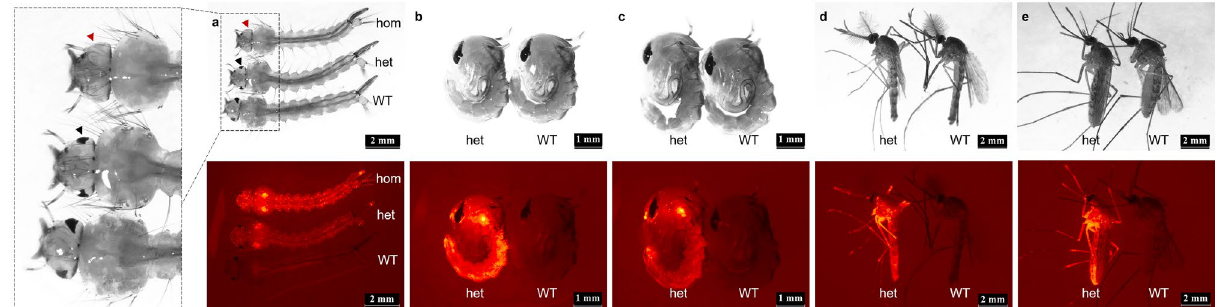
Figure 3. Phenotype of kmo knock-in in different life stages of C. quinquefasciatus (AGG2069 and wild-type). Photomicrographs of various developmental stages, in each case white light (top) and red fluorescence below. ( a ) late larvae. Pigmented eyes are clearly visible in wildtype (WT) and heterozygotes (het, one eye is indicated with a black arrowhead); this eye pigment is missing in homozygotes (hom, one eye indicated with red arrowhead). ( b ) Male pupae ( c ) Female pupae ( d ) Male adults ( e ) Female adults). Leica DFC camera settings: Brightness 82%, saturation 0 and Gamma 0.71 (for white light images) and Brightness 82%, Saturation 0.146 and Gamma 0.40 (mCherry—red fluorescence).